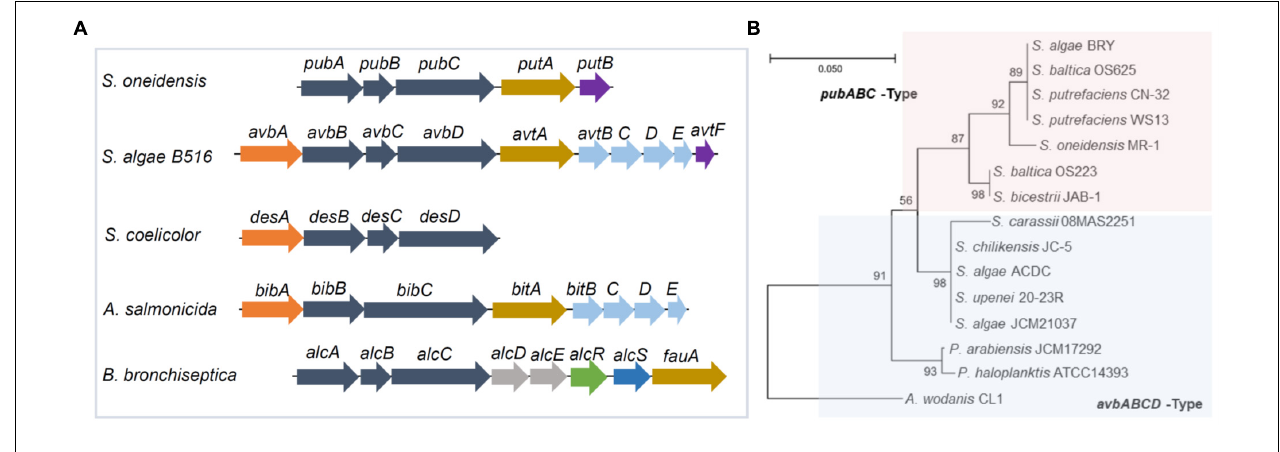
FIGURE 3 | Gene clusters for biosynthesis of cyclic dihydroxamate siderophores in bacteria. (A) The synthetic gene cluster. Genes in dark blue, NIP systems; in orange, decarboxylases; in brown, TBDRs; in purple, siderophore reductases; in light blue, siderophore ABC transporters for entering the cytoplasm; in sky blue, siderophore exporter; in green, transcriptional regulator; in red, MFS-family siderophore exporter; in gray, functionally unknown. (B) Phylogenetic analysis of representative Shewanella having the Pub and Avb systems. Shown was a maximum likelihood tree generated using 16s rRNA DNA sequences with 1,000 bootstrap repetitions. Included are Shewanella strains carring a pub cluster (pink area) as well as Shewanella strains and three other bacterial strains carrying an avb cluster (blue area). S, Shewanella ; P, Pseudoalteromonas ; A, Aliivibrio